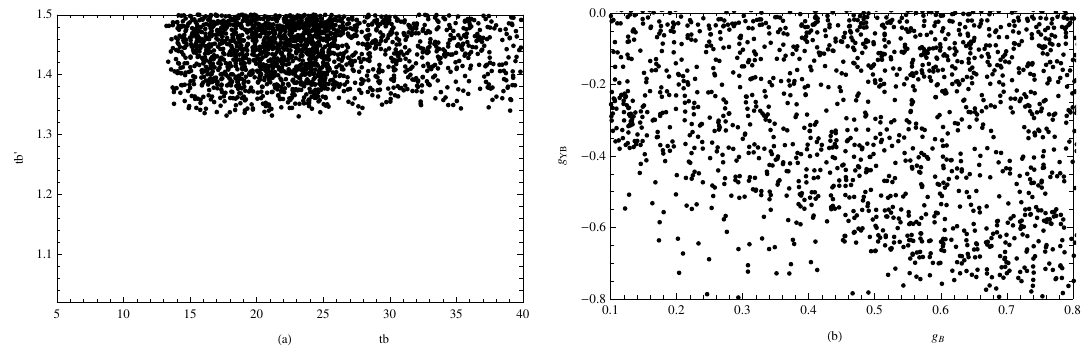
Figure 1 . The changes of parameters tb versus tb ′ and g B versus g Y B .